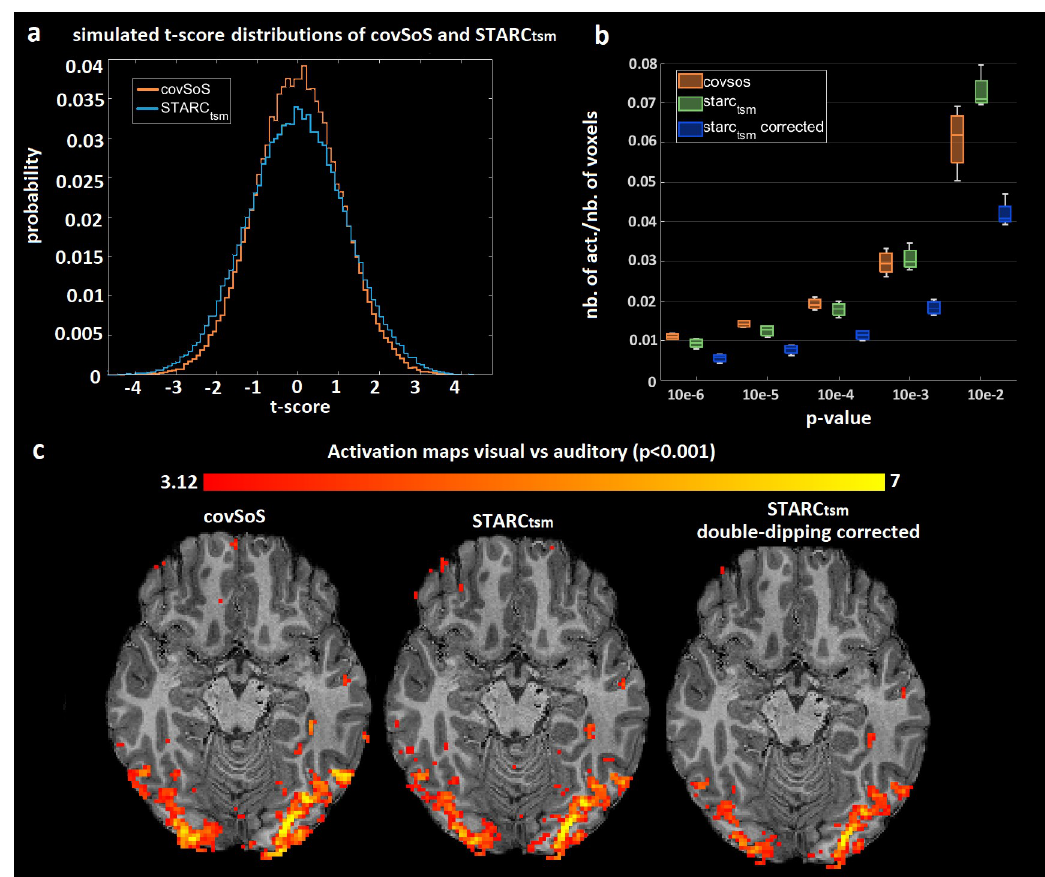
Fig 4. Double-dipping results. a–T-score distributions of covSoS and STARC tsm from noise signals and Monte Carlo simulations. The distribution of STARC tsm under the null hypothesis is distorted compared to covSoS because of double-dipping. b–Total number of activations relative to the total number of voxels at different p-values and for covSoS, STARC tsm and its double dipping corrected version for the in vivo scan. After correction, the number of activations from STARC tsm markedly drops. c–Activation maps on one volunteer for visual vs auditory contrast at p < 0.001 (no correction). After double-dipping correction, activations are weaker and clusters smaller.